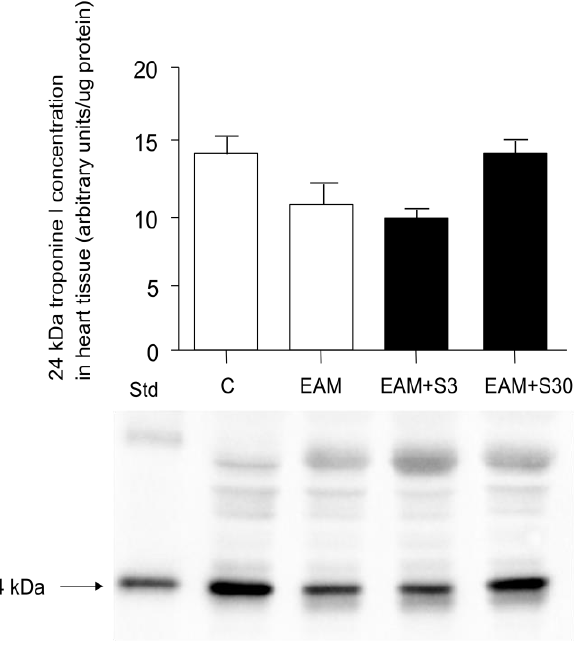
Figure 3. 24-kDa troponin I (TnI) levels in heart tissue and representative TnI protein quantity in heart homogenates determined by Western blot. C indicates not immunized group without simvastatin; EAM—group with induced EAM without simvastatin; EAM+S3—low-dosage simvastatin EAM group (3 mg/kg/d); EAM+S30—high-dosage simvastatin EAM group (30 mg/kg/d); 24 kDa indicates TnI.